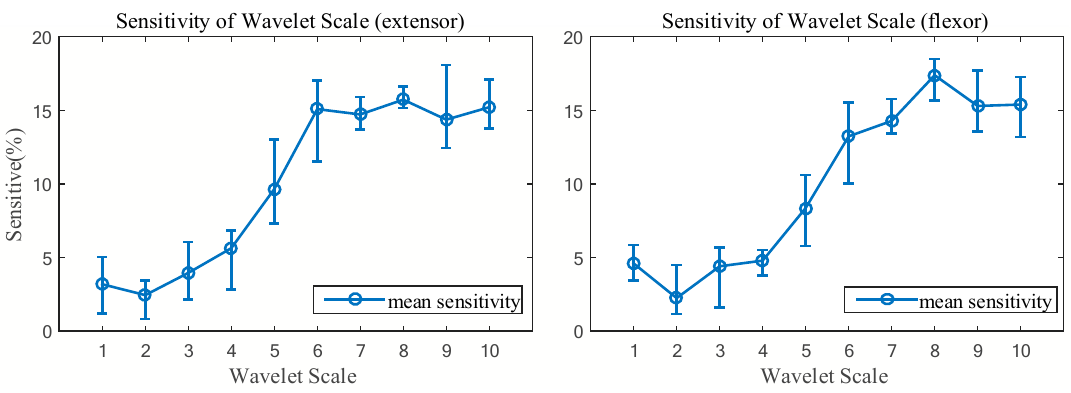
Figure 5. Sensitivity distribution of the ten wavelet scales to handgrip force.